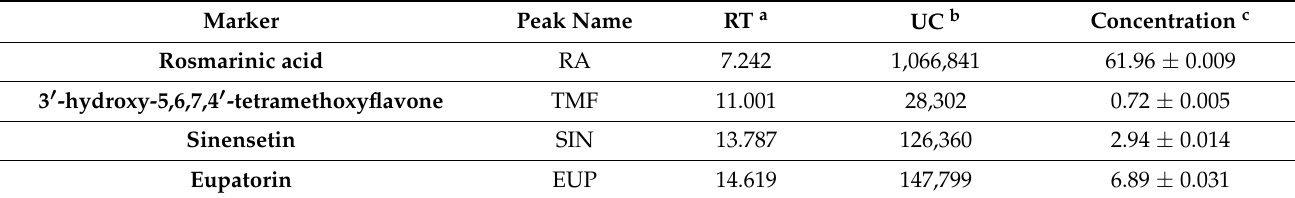
Figure 2. HPLC chromatogram of the O. aristatus extract analysis. Table 1. HPLC chromatography analysis of the main makers of O. aristatus